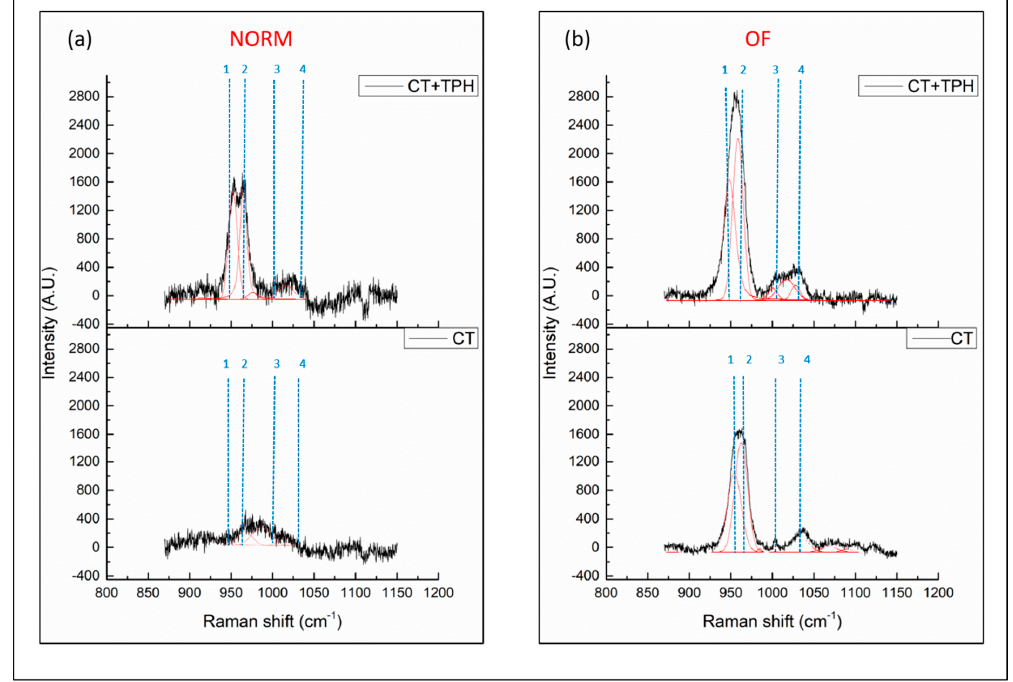
Figure 3. RAMAN spectra of samples CT and CT + TPH cultured with ( a ) the normal medium, ( b ) the medium with the osteoinductive factors. medium with the osteoinductive